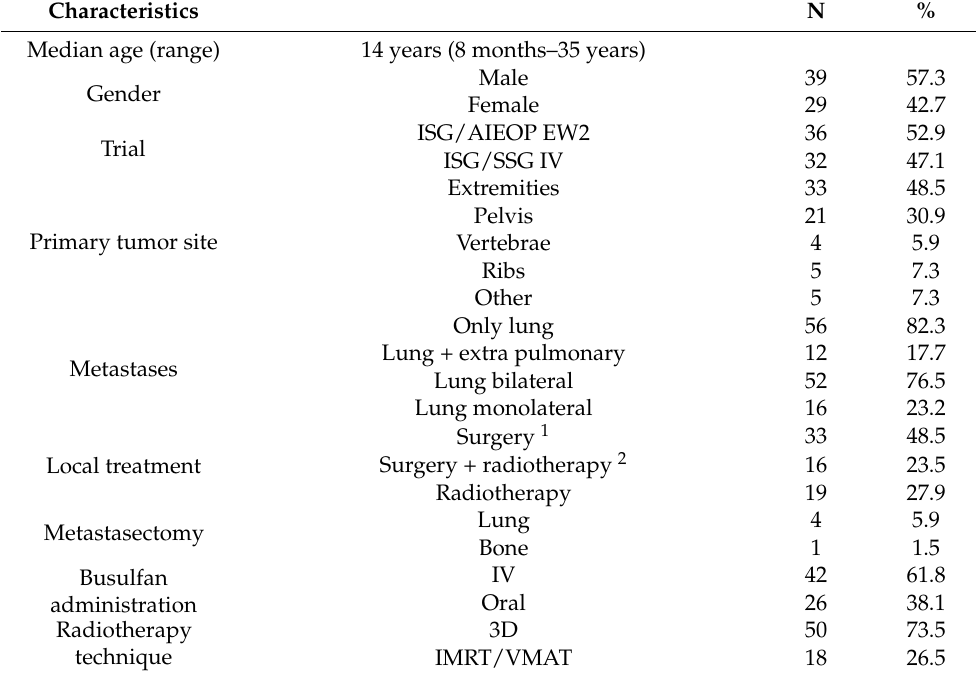
Table 1. Patients characteristics.